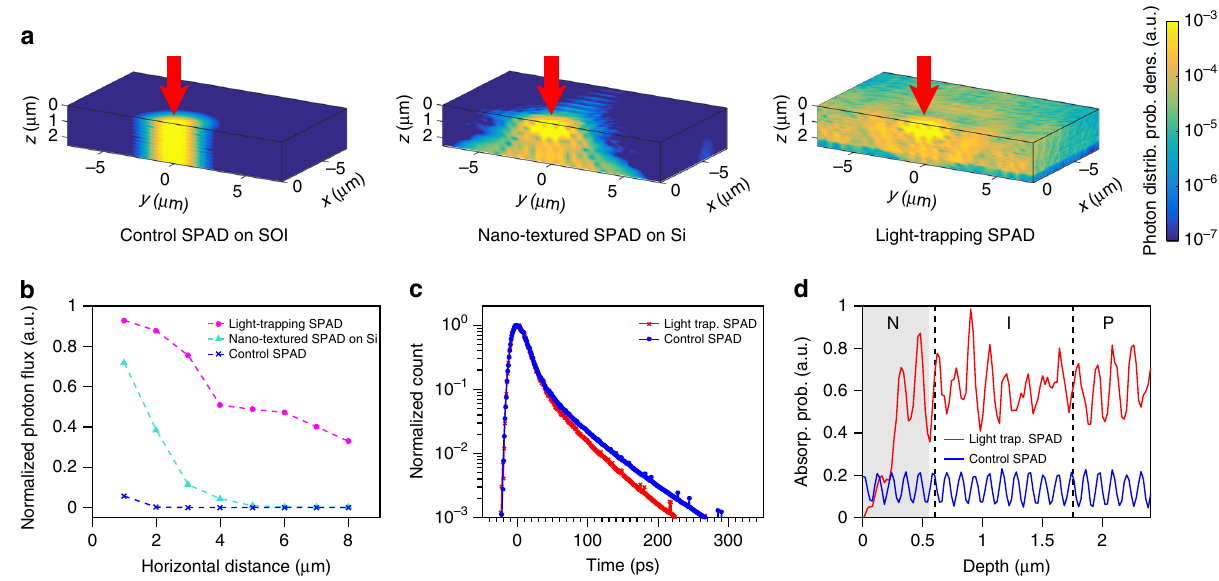
Fig. 2 Simulation of photon distribution probability and jitter performance. a FDTD simulation of 850 nm wavelength photon distribution in a control SPAD ( left ), nano-textured SPAD on Si substrate ( middle ), and light-trapping SPAD ( right ). Photons are incident in positive Z direction. The color bar on the right shows the color map of photon distribution probability density. b Normalized fl ux of 850 nm photons propagating varying horizontal distance in a control SPAD ( blue cross ), nano-textured SPAD on Si substrate ( turquoise triangle ) and light-trapping SPAD ( magenta circle ). c Monte Carlo simulation of jitter distribution at given photon absorption distribution for a control SPAD ( blue ) and light-trapping SPAD ( red ). d Simulated photon absorption at varying depths for a control SPAD ( blue ) and light-trapping SPAD ( red ), with top surface at 0 μ m. Shaded areas correspond to regions being nano-structured. Dashed lines denote respective doping layer in an NIP junction from left (surface) to right (substrate)